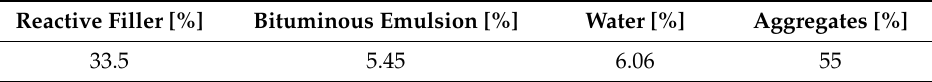
Table 4. First experience RTM’s composition.